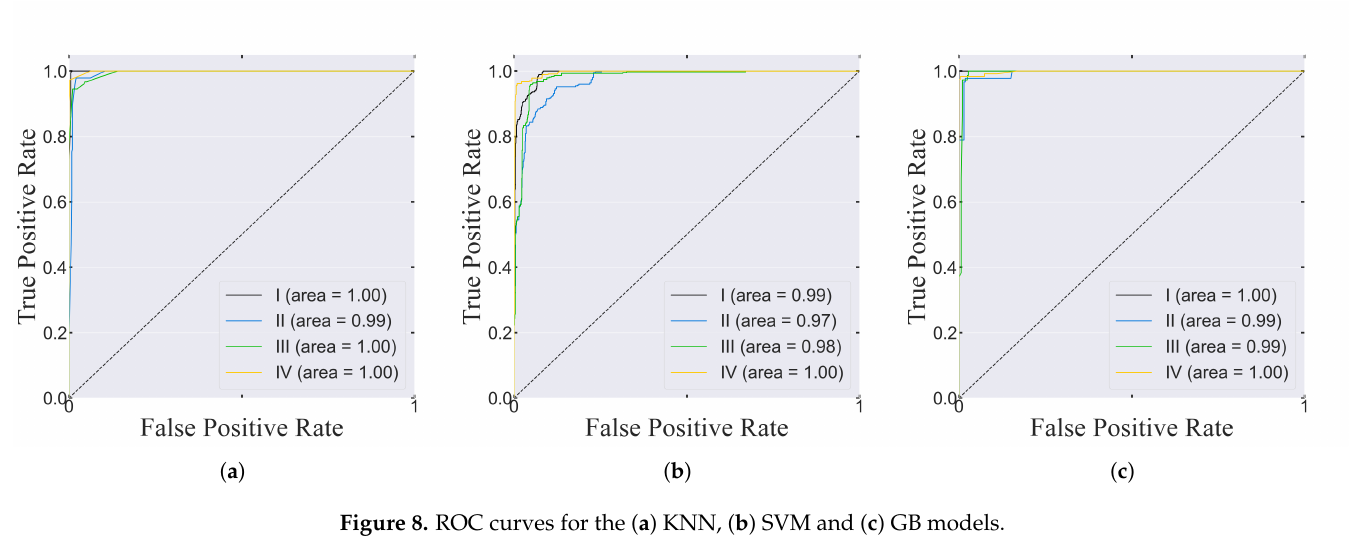
Figure 8. ROC curves for the ( a ) KNN, ( b ) SVM and ( c ) GB models. The high accuracy of the GB model can be explained by the quality of the fit of the learning curve, as the training and cross-validation loss difference was greater for this classifier than for the other two models. To account for the slight imbalanced data, the F1 score was also considered, as this is a more adequate tool to measure these type of data sets given that it gives more weight to classified samples in the minority class [43]. According to the average F1 score of each class across all three classifiers, the severity levels I (0.96) and IV (0.97) appear to have the highest values, in contrast to levels II (0.91) and III (0.92). Table 4. Performance metrics per class of each model tested.